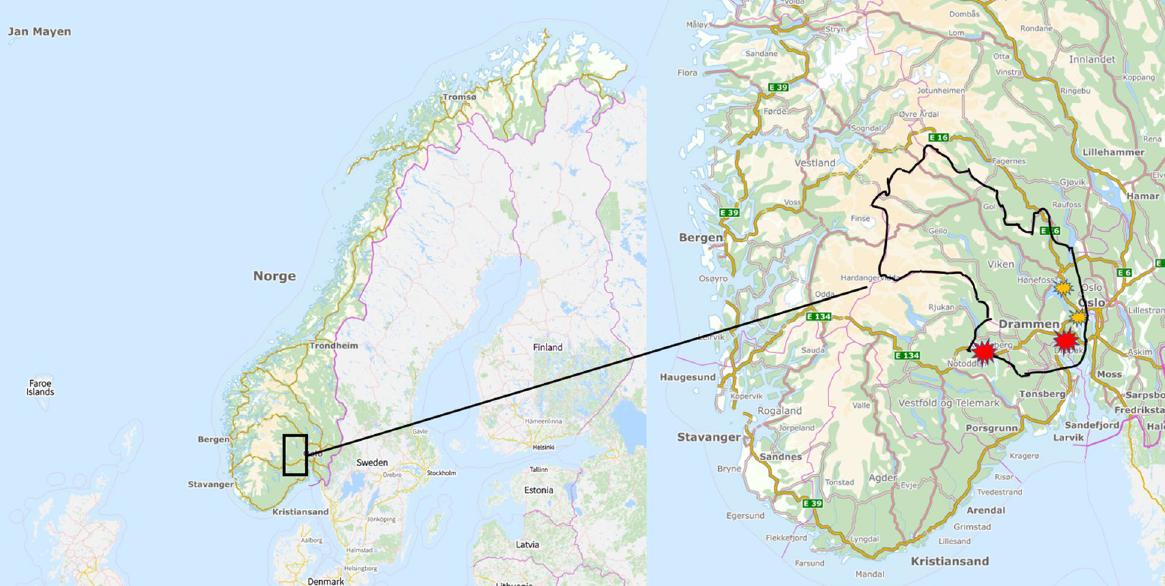
Fig. 1 The catchment area of VVHT. The catchment area of VVHT within the black delineation. Red stars indicate locations containing both public and private providers with MRI facilities. Yellow stars indicate the location of public providers with MRI